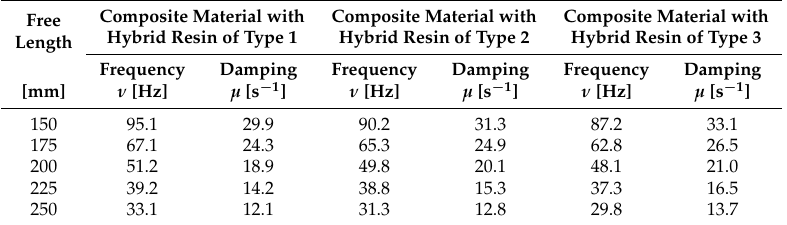
Table 7. Behavior under vibrations of samples from composites with matrix of hybrid resin of type 1, 2 and 3, reinforced with the first type of flax fabric.